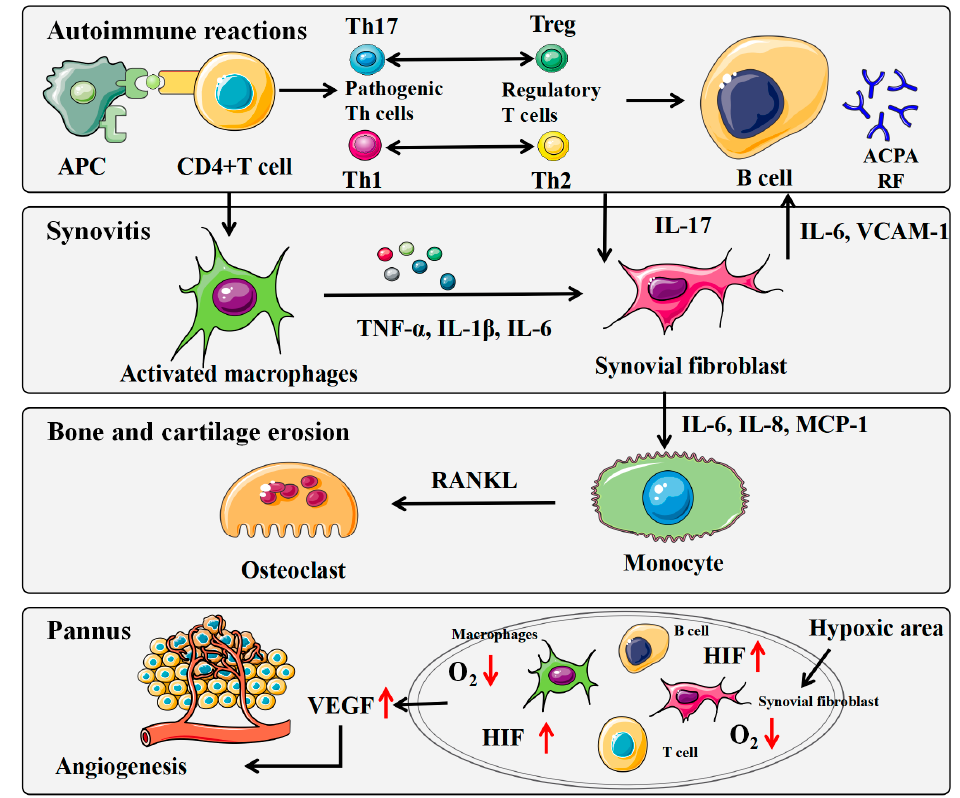
Figure 1. The pathological mechanism of RA. APC: antigen-presenting cell; DC: dendritic cell; ACPA: anti-citrullinated protein/peptide antibodies; RF: rheumatoid factor; TNF: tumor necrosis factor; IL: interleukin; VCAM-1: vascular cell adhesion molecule-1; MCP-1: monocyte chemoattractant protein-1; RANKL: receptor activator of nuclear factor- κ B ligand; VEGF: vascular endothelial growth factor; HIF: hypoxia-inducible factor; Red arrow mean up or down regulation.